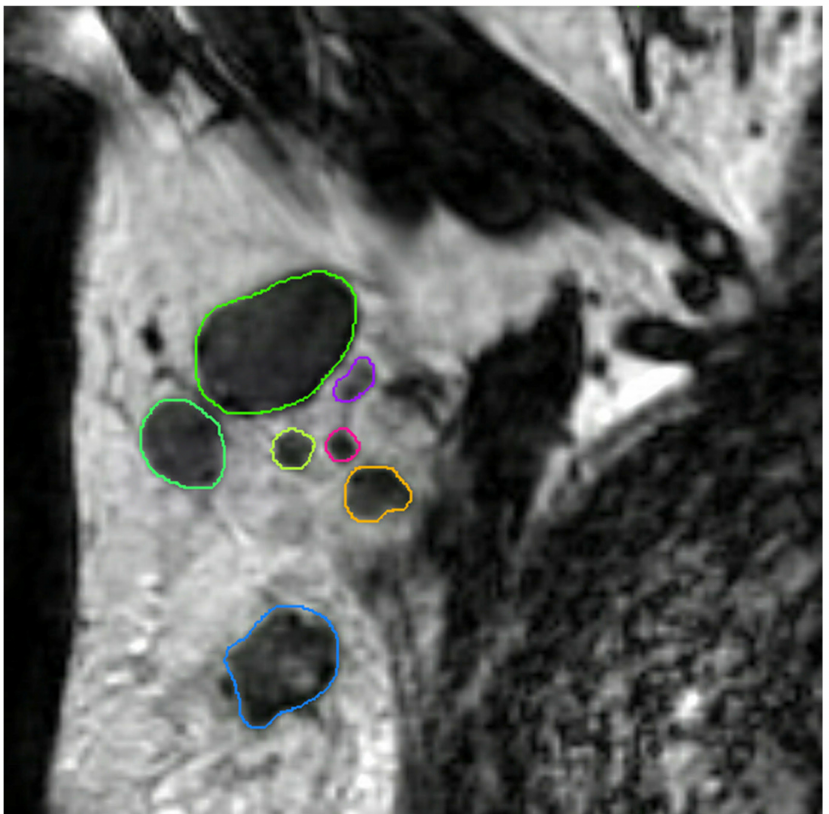
Figure 4. Coronal T2-weighted dedicated axillary MR image of a 55-year old woman with invasive breast cancer, who was treated with mastectomy and axillary lymph node dissection (pT1N2). The MR image demonstrates an example of delineations of lymph nodes in the right axilla on the MIM